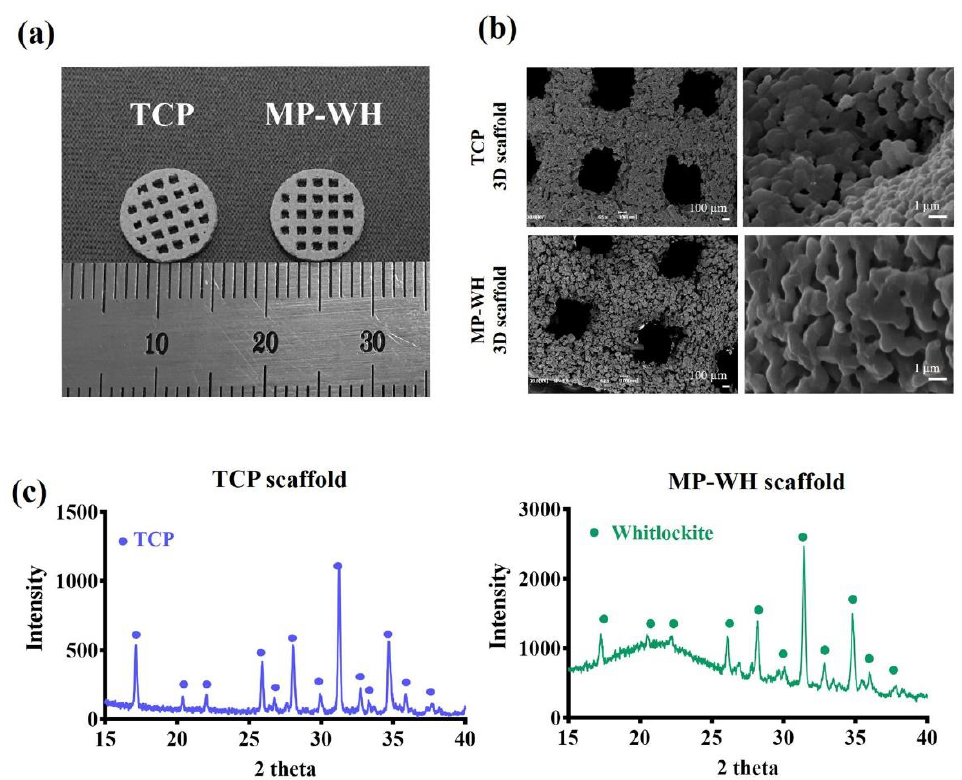
Figure 1. Fabricated open porous 3D scaffold using the 3D printing machine ( a ) and scanning electron microscope image of the 3D scaffold ( b ). X-ray diffraction analysis ( c ) of the fabricated definitive 3D scaffold. TCP, tricalcium phosphate; MP-WH, marine plankton-derived whitlockite.